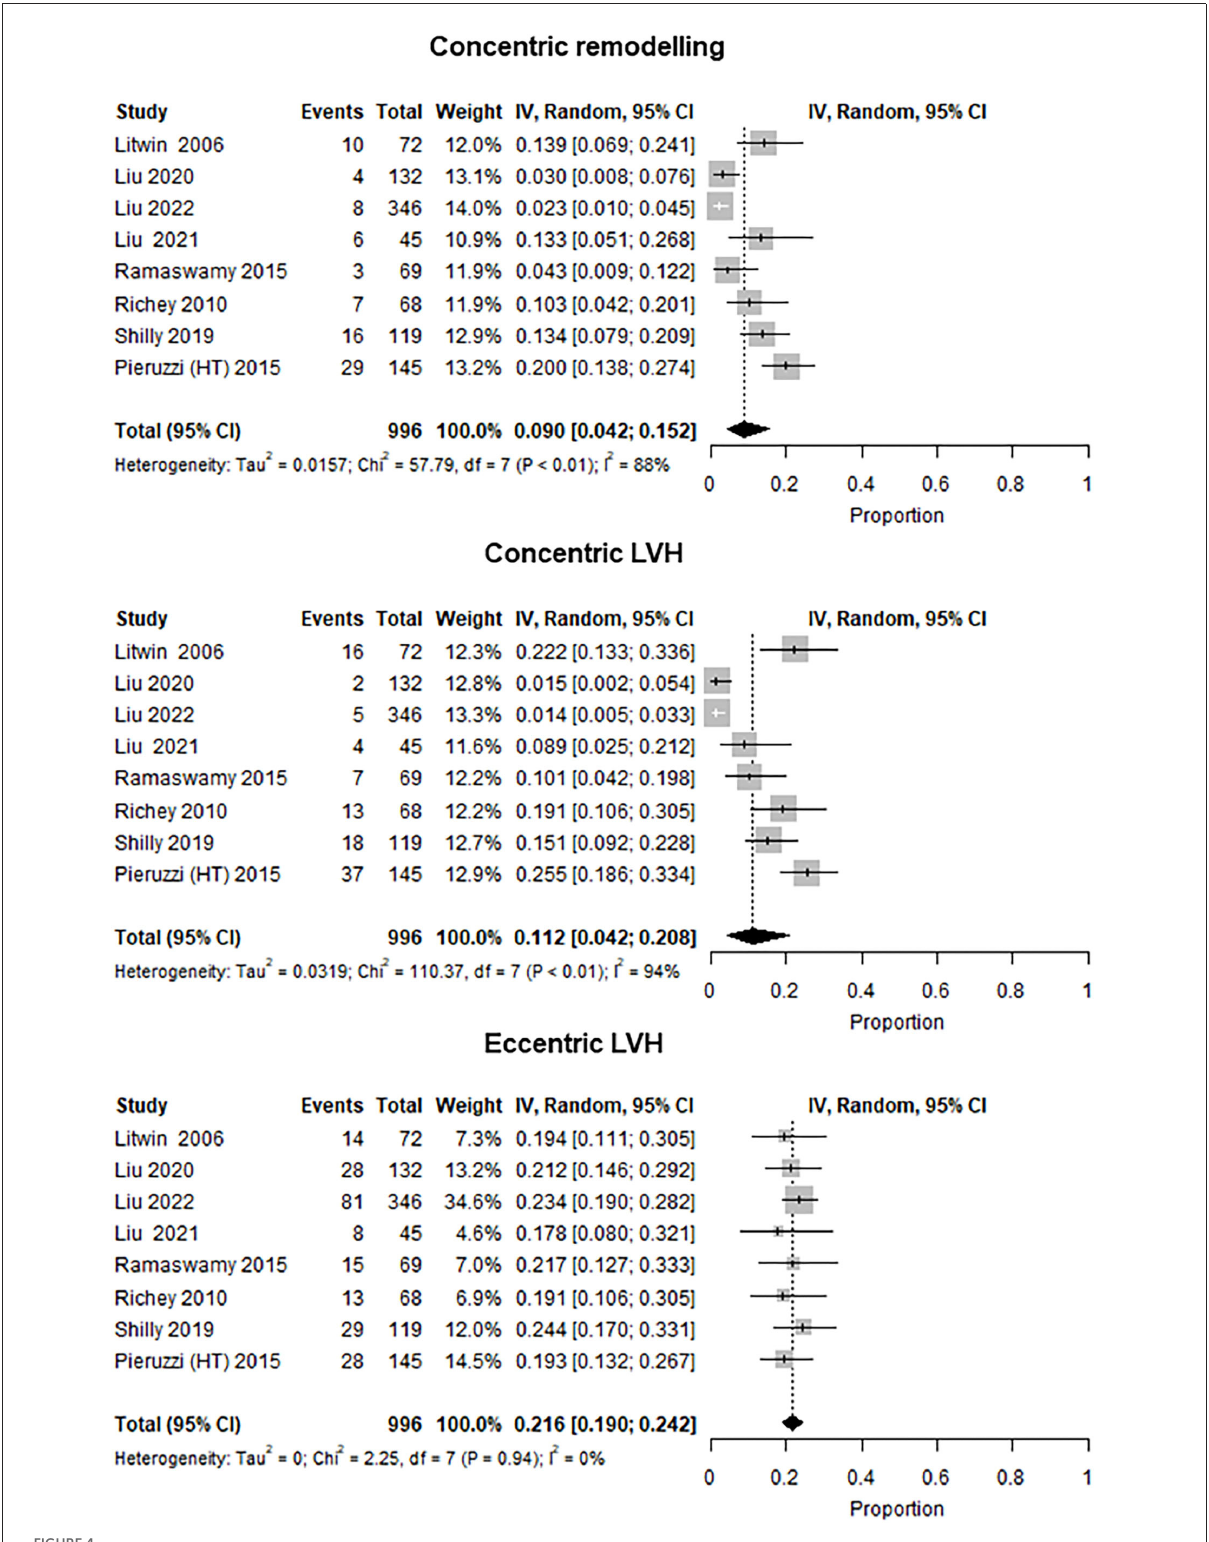
FIGURE4 Forest plot showing the prevalence of LV geometry patterns (concentric remodeling, concentric LVH, and eccentric LVH) in studies with available data (eight studies). Three studies were excluded as being mixed [included community and specialty clinic patients: Agu et al. (31) and Gupta-Malhotra et al. (45)] or community samples